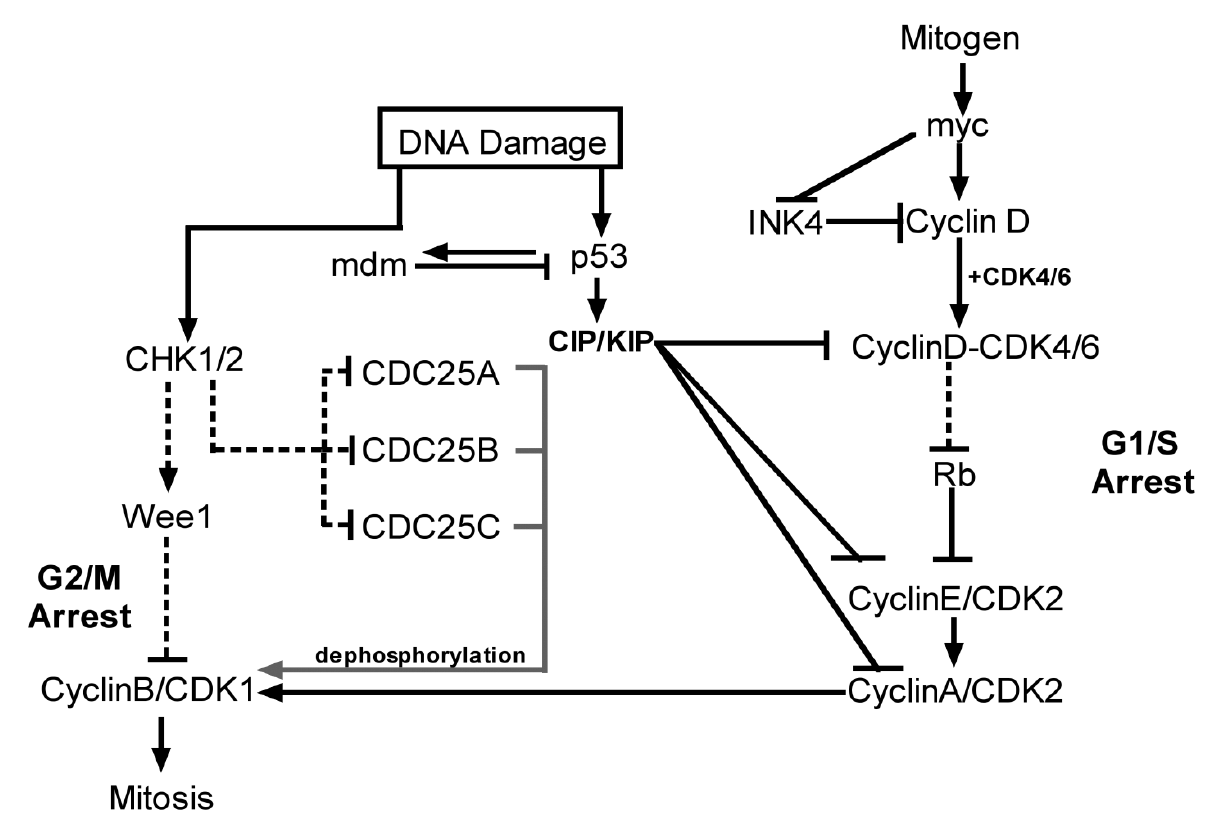
Figure 3: The DNA damage pathway and its crosstalk with the cell cycle. Lines with arrow heads represent activation while lines with bar heads represent deactivation, dotted lines with arrow heads indicate activation via phosphorylation and dotted lines with bar heads denote phosphorylational inactivation. Grey lines with arrow heads represent dephosphorylation. After DNA damage, P53 and checkpoint kinases Chk1/Chk2 are activated. P53 activation results in concomitant rise in the CIP/KIP proteins, P21 and P27 which inhibit cyclin/CDK complexes, blocking the cell cycle progression which results in G1/S arrest. The activated Chk1/Chk2 kinases activate Wee1 protein kinase as well as inhibit the function of Cdc25 group of phosphatases, which normally dephosphorylate and activate cyclin/cdk complexes. The inactivation of cyclinB/CDK1 activity via both phosphorylational inactivation by Wee1 as well as inhibition of its activating phosphatases by Chk1/Chk2 result in G2/M arrest. Thus in a normal cell, both G1/S and G2/M checkpoints are functional and may arrest the cell cycle upon DNA damage, to allow time for DNA